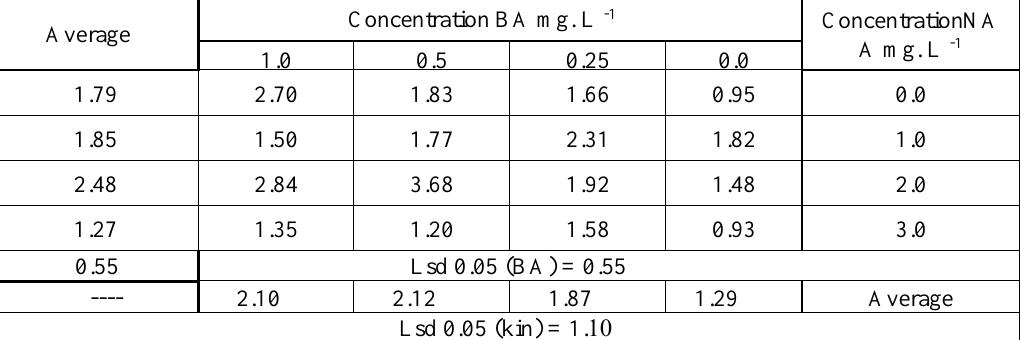
Table 7. Effect of BA and NAA Auxin and their Interaction on Average Dry Weight (gm) of Leaf Stevia Callus in Vitro.